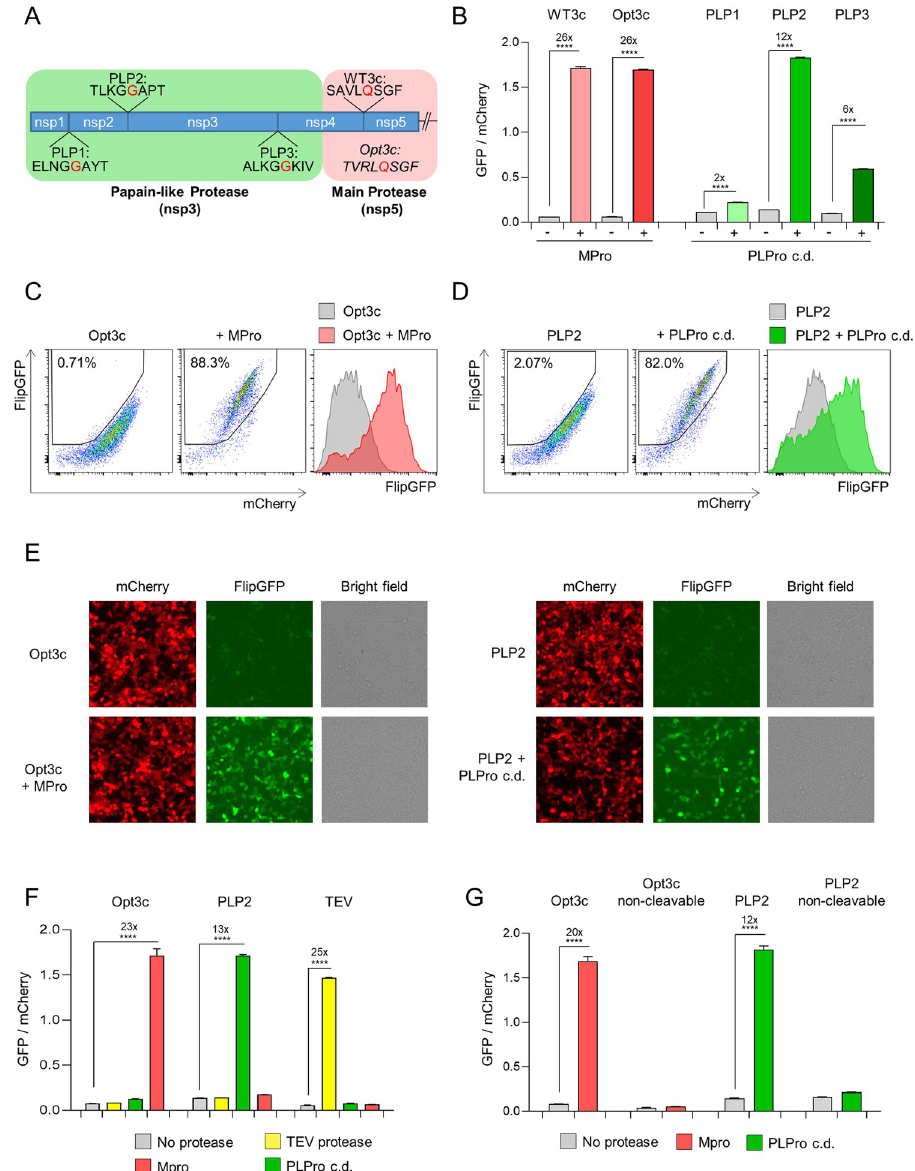
Fig 1. Cell-based biosensors of SARS-CoV-2 protease activity. ( A ) Diagram of pp1a polyprotein showing candidate SARS-CoV-2 cleavage sequences for Papain-like Protease (PLPro; PLP1-3) and Main Protease (MPro; WT3c and Opt3c). Further details on sequence selection are available in the Materials and methods . Sites of cleavage are highlighted in red (C-terminal side of indicated amino acid). ( B-D ) Activation of FlipGFP-based reporters by recombinant SARS-CoV-2 protease expression. HEK293T cells were co-transfected with BFP and indicated FlipGFP- based reporter constructs encoding candidate MPro or PLPro cleavage sequences ± MPro, PLPro c.d., or empty pcDNA3.1. Illustrative flow cytometry data for Opt3c-FlipGFP ( C ) and PLP2-FlipGFP ( D ) are shown. ( E ) Detection of FlipGFP-based reporter activation by epifluorescence microscopy. HEK293T cells were co-transfected with Opt3c- FlipGFP biosensor plus/minus MPro (left panel) or PLP2-FlipGFP biosensor plus/minus PLPro (right panel). FlipGFP and mCherry fluorescence were analysed by epifluorescence microscopy 24 h post-transfection. mCherry, red. FlipGFP, green. Representative of 3 independent experiments. ( F ) Protease-specificity of FlipGFP-based reporters. HEK293T cells were co-transfected with BFP and indicated FlipGFP biosensors ± MPro, PLPro c.d., TEV protease or empty pcDNA3.1. ( G ) Sequence specificity of FlipGFP-based reporters. HEK293T cells were co-transfected with BFP and indicated FlipGFP biosensors ± MPro, PLPro or empty pcDNA3.1. Further details on non-cleavable mutants are available in the Materials and methods . For all flow cytometry experiments ( B-D and F-G ), FlipGFP and mCherry fluorescence in BFP+ cells were analysed 24 h post-transfection. An indicative gating strategy is shown in S2A Fig ,